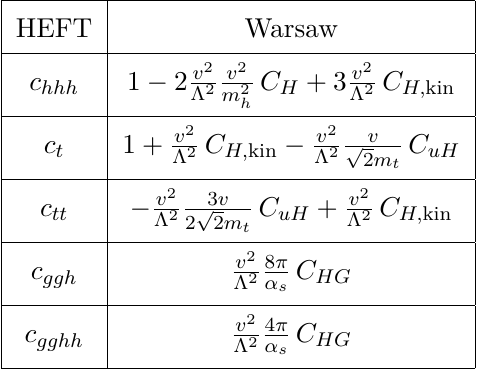
Table 1 . Translation at Lagrangian level between different operator basis